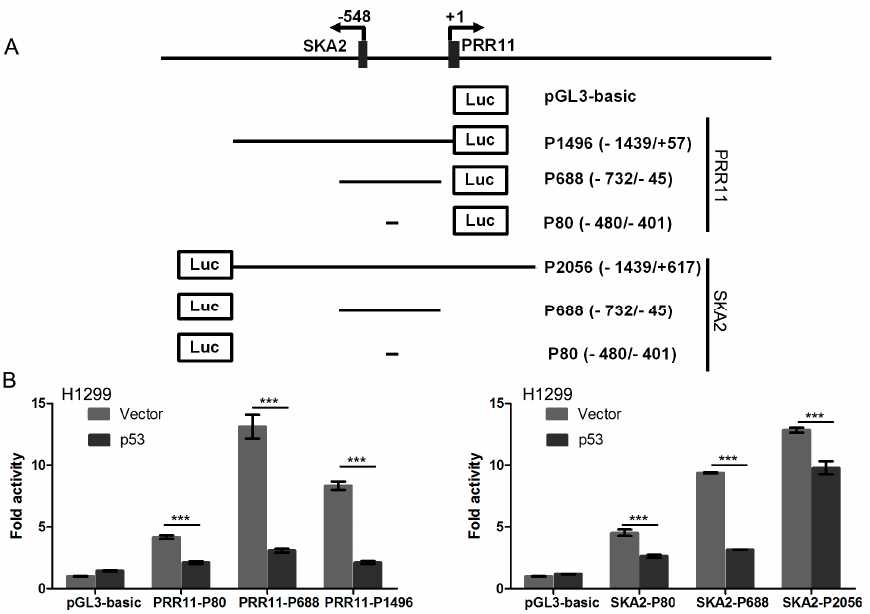
Figure 1. Overexpression of p53 represses PRR11-SKA2 promoter activity. ( A ) Schematic representation of PRR11-SKA2 bidirectional promoter reporter constructs. The positions relative to the major transcriptional initiation site of PRR11 (+1) are indicated. The constructs were named as “P(promoter)-fragment length (start position/end position)”; ( B ) Luciferase reporter assay. H1299 cells were transiently co-transfected with the indicated luciferase reporter constructs together with p53 expression vector by using Lipofectamine 2000 transfection reagent. Forty-eight hours after transfection, firefly and renilla luciferase activities were measured by Dual Luciferase Assay System (Promega, Madison, Wisconsin, USA). Data obtained from a representative of at least three independent experiments were shown as fold induction compared to the activity of cells transfected with the empty pGL3-basic vector. The results are presented as the mean and SD of triplicates from a representative experiment. *** p < 0.001.